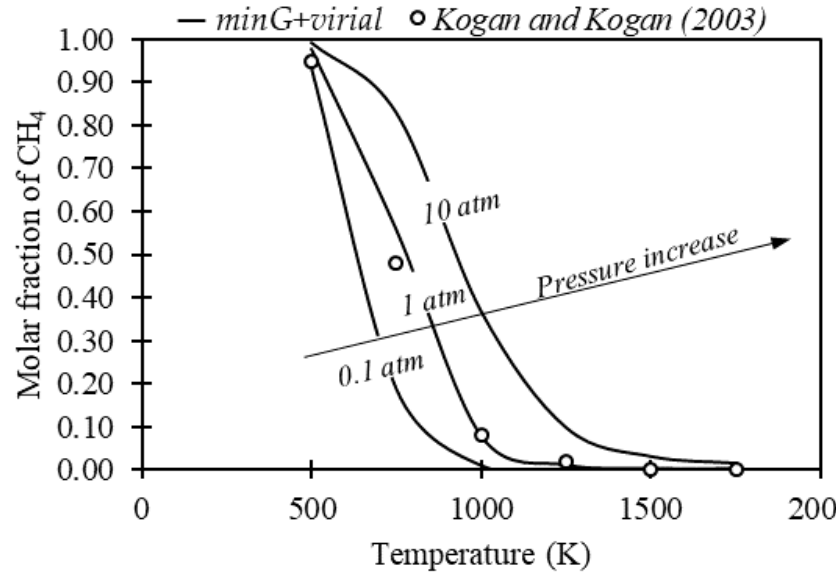
Figure 6. Molar fraction of hydrogen as a function of temperature for fixed pressures with 1 mol of methane in the feed.